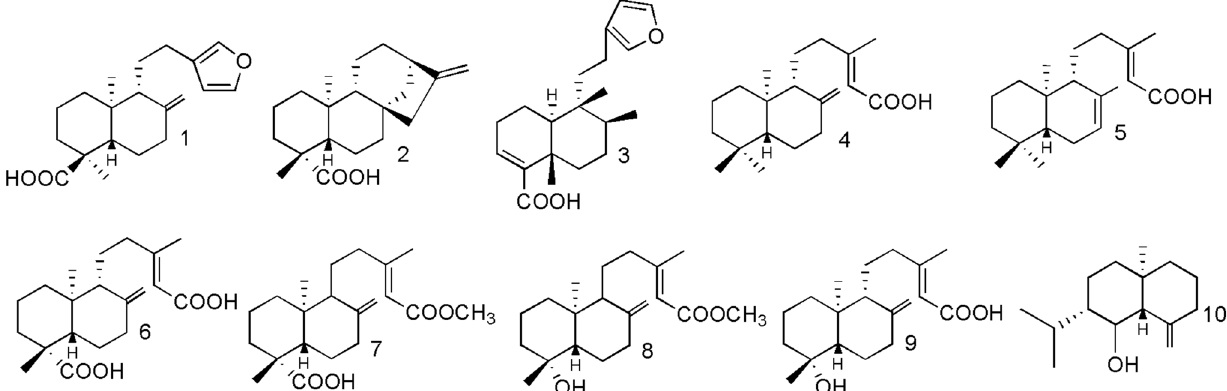
Figure 1. Chemical structures of the tested compounds: polyalthic acid ( 1 ), kaurenoic acid ( 2 ), hardwickiic acid ( 3 ), ent -Copalic acid ( 4 ) and its isomer [(13E)- ent -labda-7,13-dien-15-oic acid; 5 ], ent -agathic acid ( 6 ), ent - agathic acid 15-methyl ester ( 7 ), ent -agatholic acid 15-methyl ester ( 8 ), ent -agatholic acid ( 9 ), and junenol ( 10